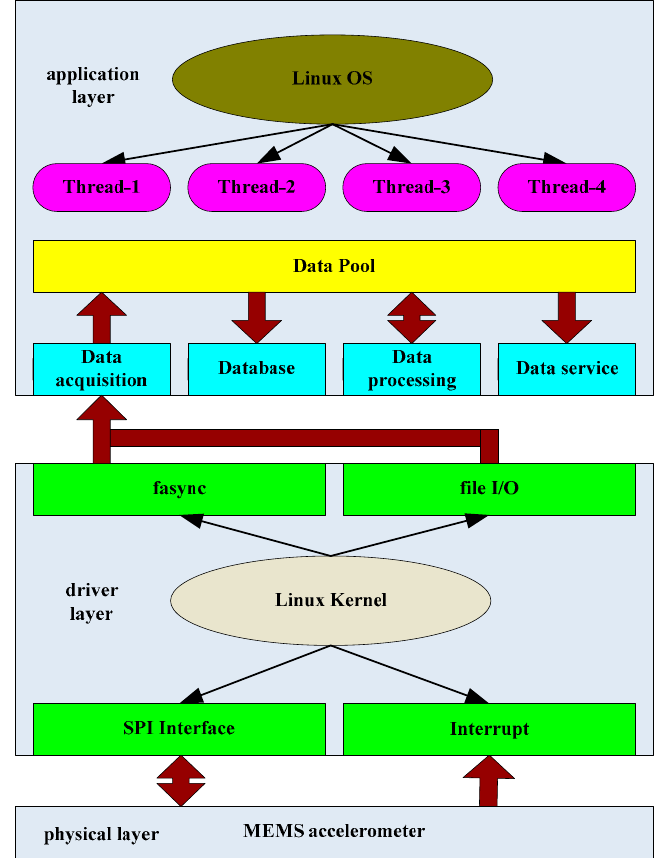
Figure 6. Flowchart representing the data collection process in our software.